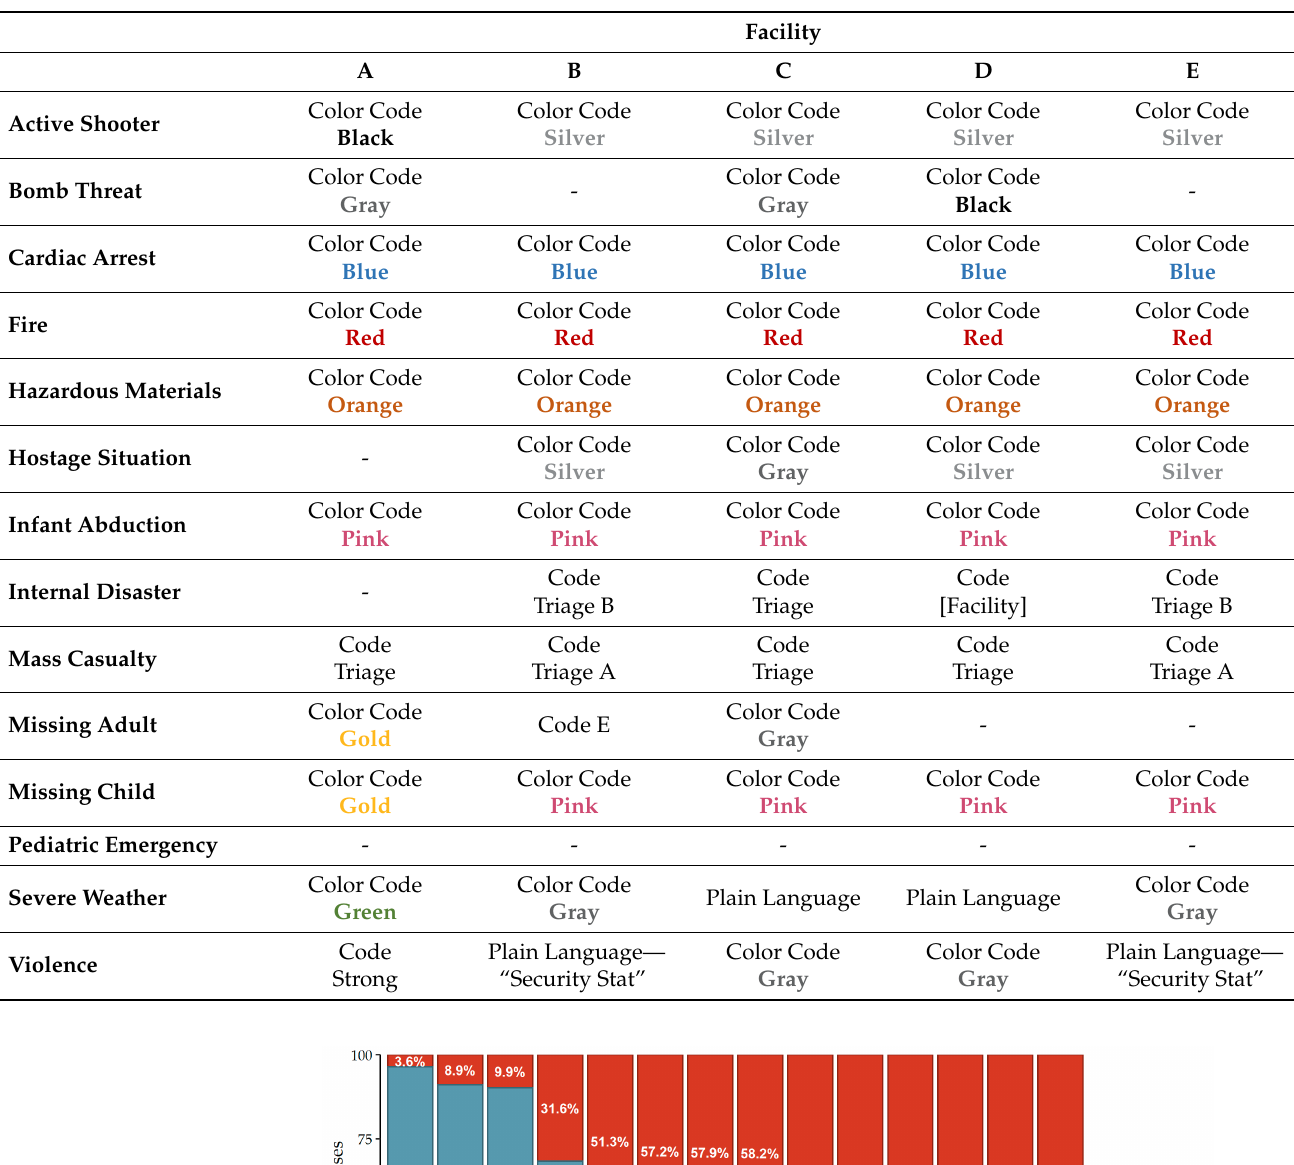
Table 3. Codes for each emergency type, as identified by each facility’s emergency operations plan.